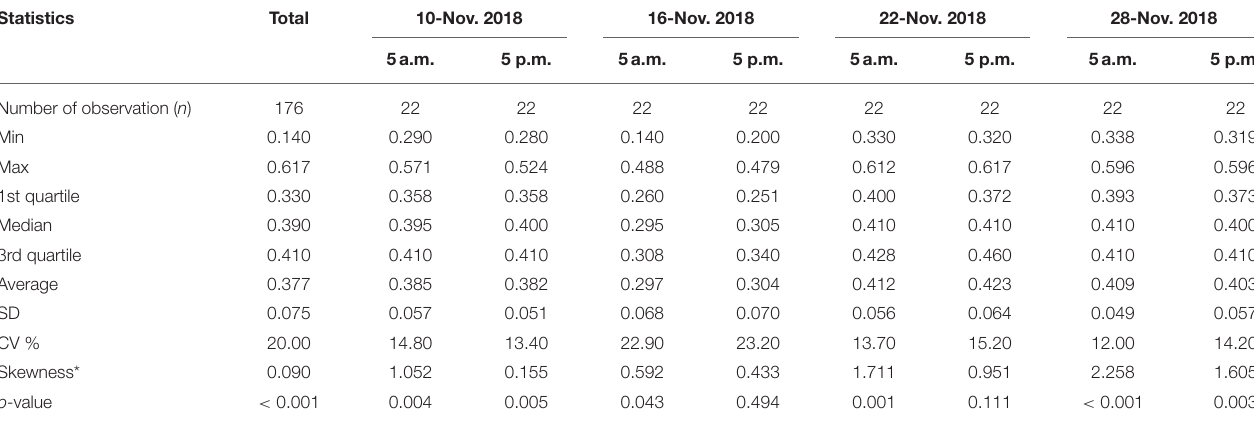
TABLE 5 | Descriptive statistics of the in-situ soil moisture (m 3 m − 3 ) over the entire 22 locations at the time of satellite overpasses.